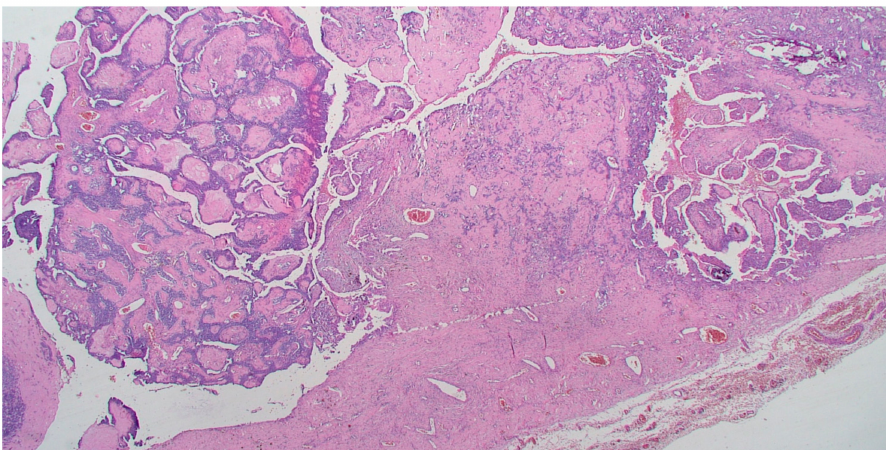
Figure 1. Transition from serous borderline tumor to low-grade serous and mesonephric-like adeno- carcinoma. (HE, 40 × ).